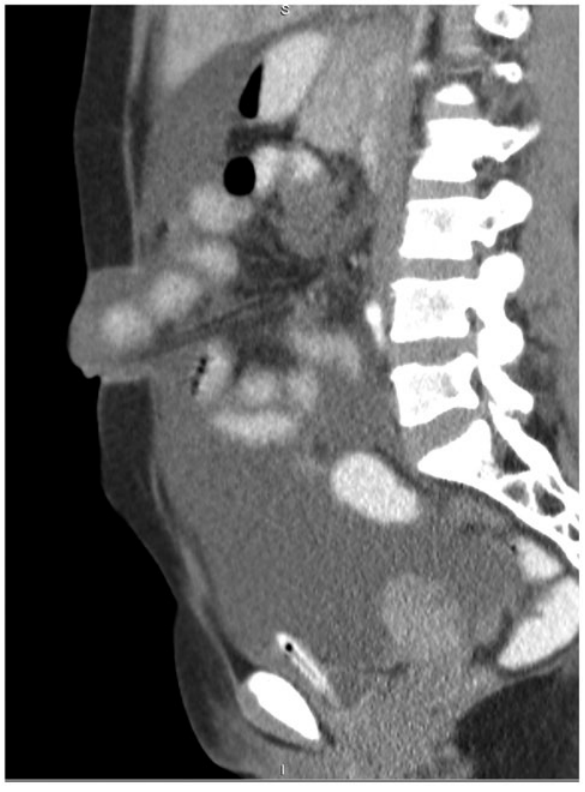
Figure 1a: Sagittal post-contrast CT showing an umbilical hernia with herniation of small bowel loops through a midline defect in the abdominal wall